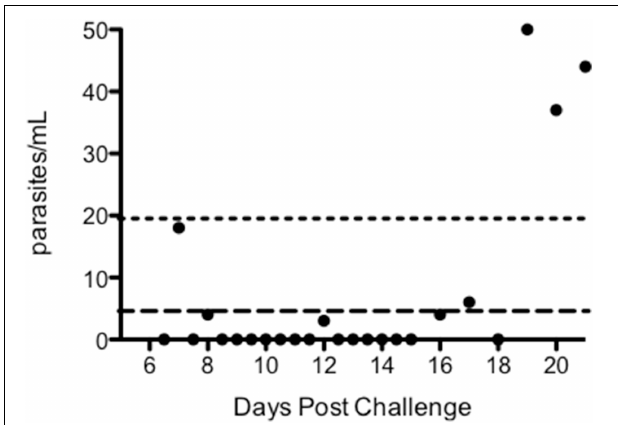
FIGURE 6 | qPCR results post-challenge for volunteer 110, group 2. Long dashed line = lower limit of detection (i.e., a probability of > 50% of ≥ 1 positive result among three replicate PCR reactions) for qPCR assay (5 parasites/mL). Short dashed line = lower limit of quantification (defined as %CV < 20%) for qPCR assay (20